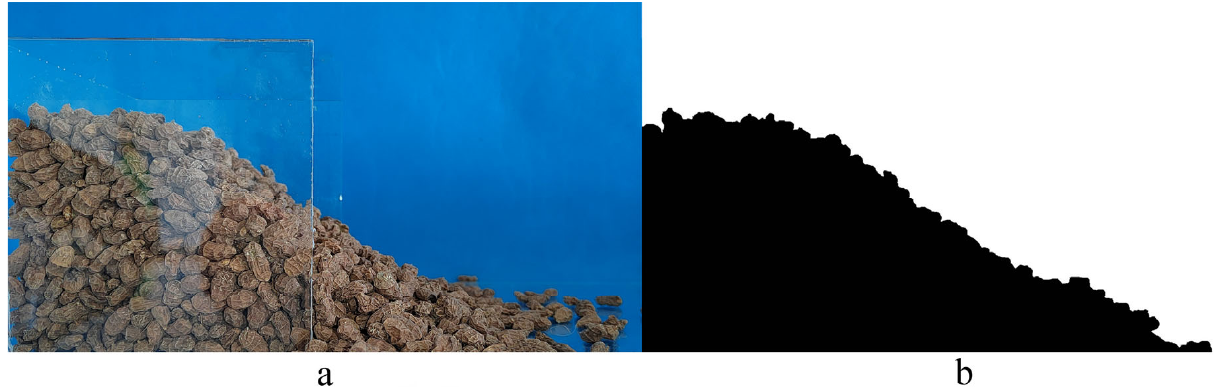
Figure 8. Piling test: ( a ) photograph of the piling test; ( b ) image binarization [22].